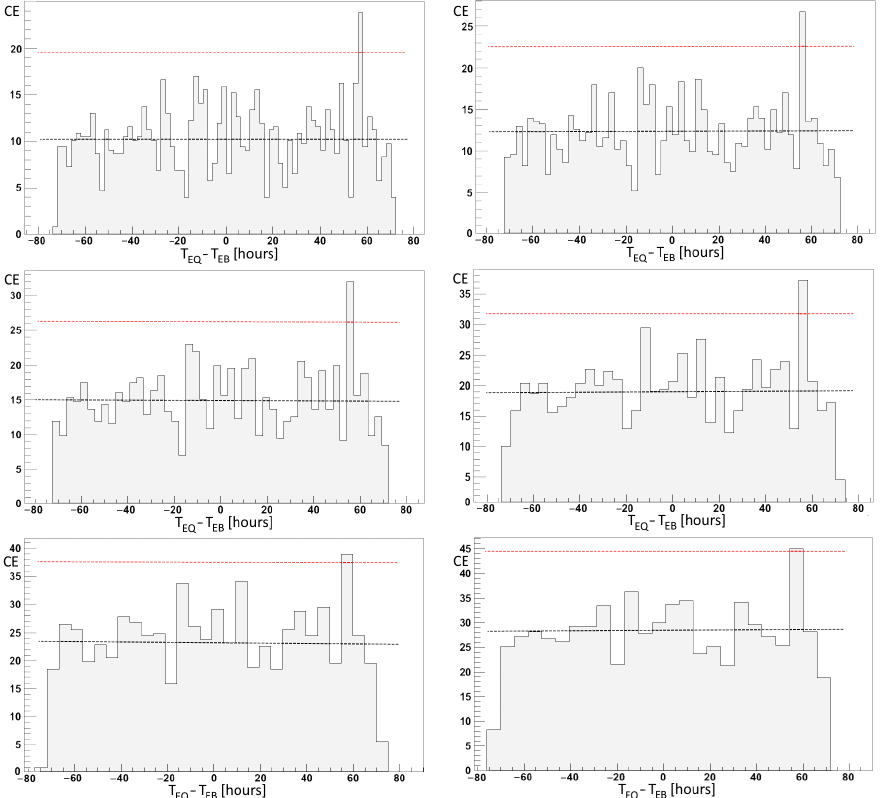
Figure 2. Correlations were obtained by filling histograms of the time difference T EQ − T EB which is positive when EBs anticipated EQs. They are plotted for different bins of 2, 2.5, 3, 4, 5, and 6 h from top left to right; the centers of correlation peaks are 57.2, 56.05, 55.8, 56.3, 57.3, and 57.2 h, respectively; averages are evidenced by the black horizontal dotted lines, while the red ones indicated the 3 σ levels; note that border bins are not completely populated as they are partially out the range of ±3 days.